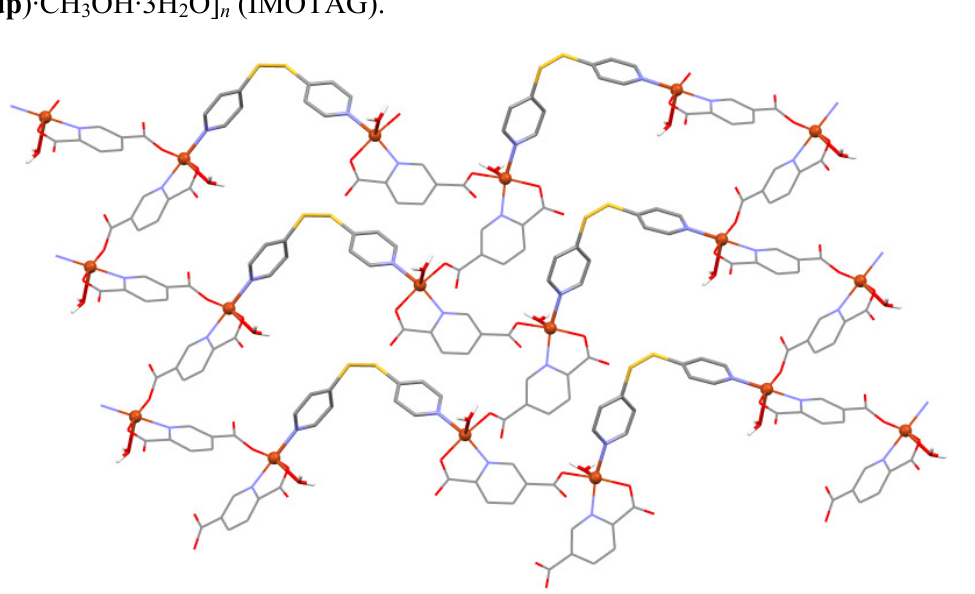
H NO )(H O)} 7 3 4 2 2